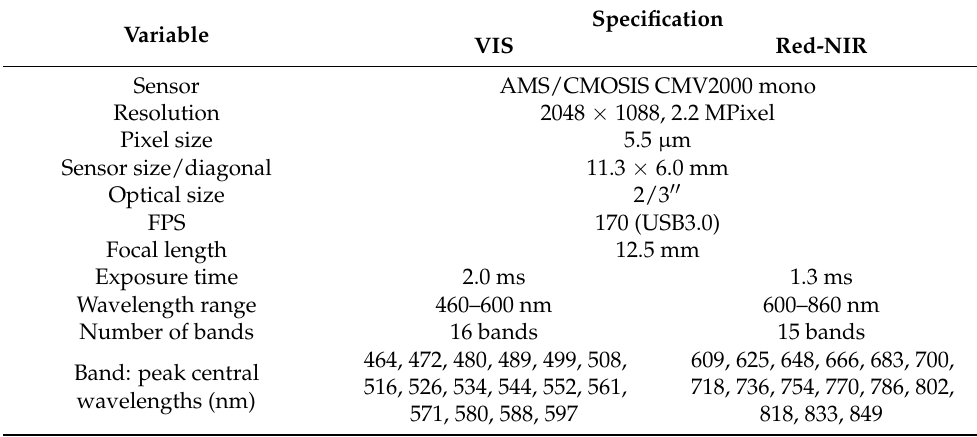
Table 2. The specifications of VIS and Red-NIR hyperspectral